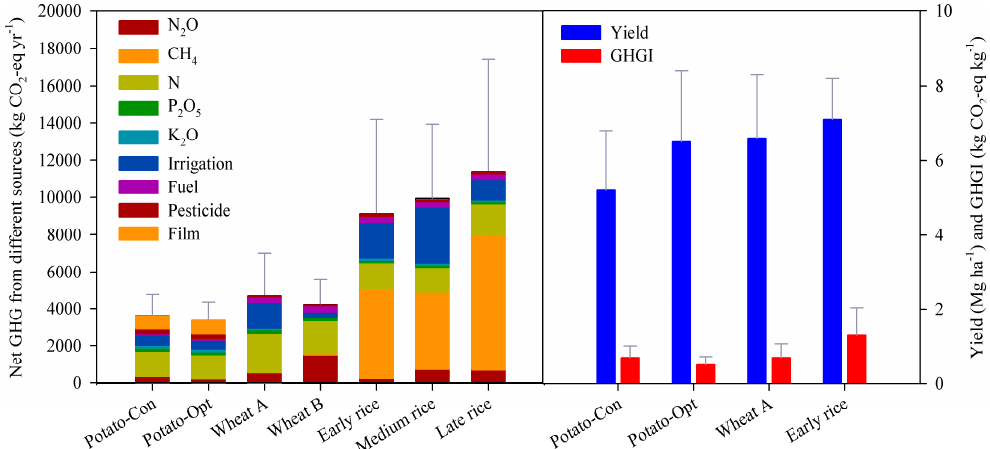
Figure 3. Total GHG emission from different CO 2 -eq emissions in conventionally grown (Potato-Con), and optimally grown (Potato-Opt) potatoes, winter wheat in the North China Plain (NCP; wheat A), winter wheat across China except for NCP (wheat B) and early, medium and late rice in China (left) and the yields and GHGI of Potato-Con, Potato-Opt, wheat A and early rice (right).